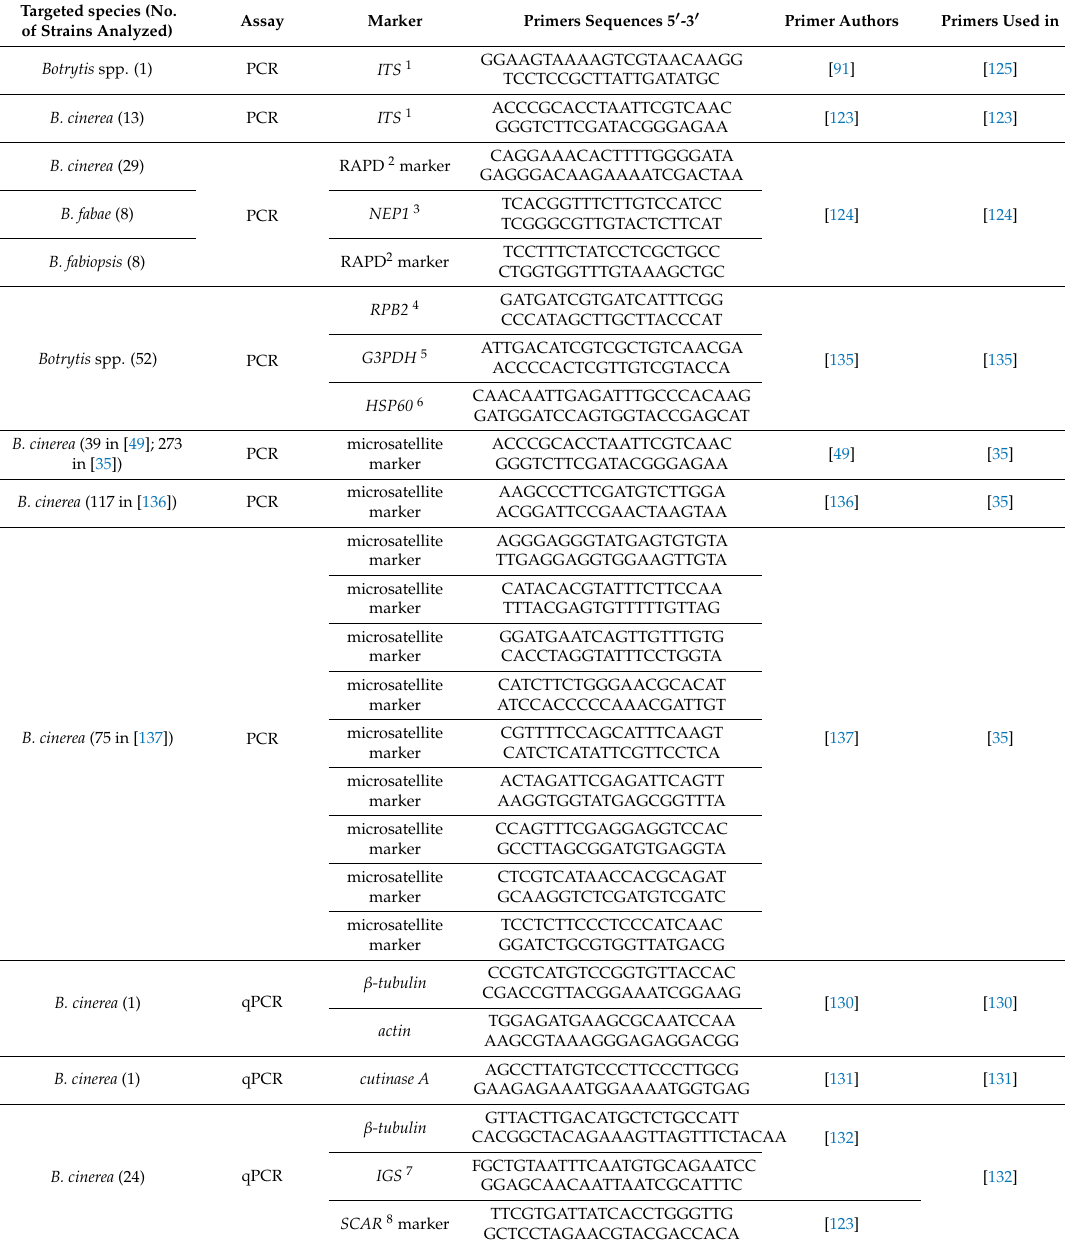
Table 4. Selected primers designed for molecular analysis of Botrytis